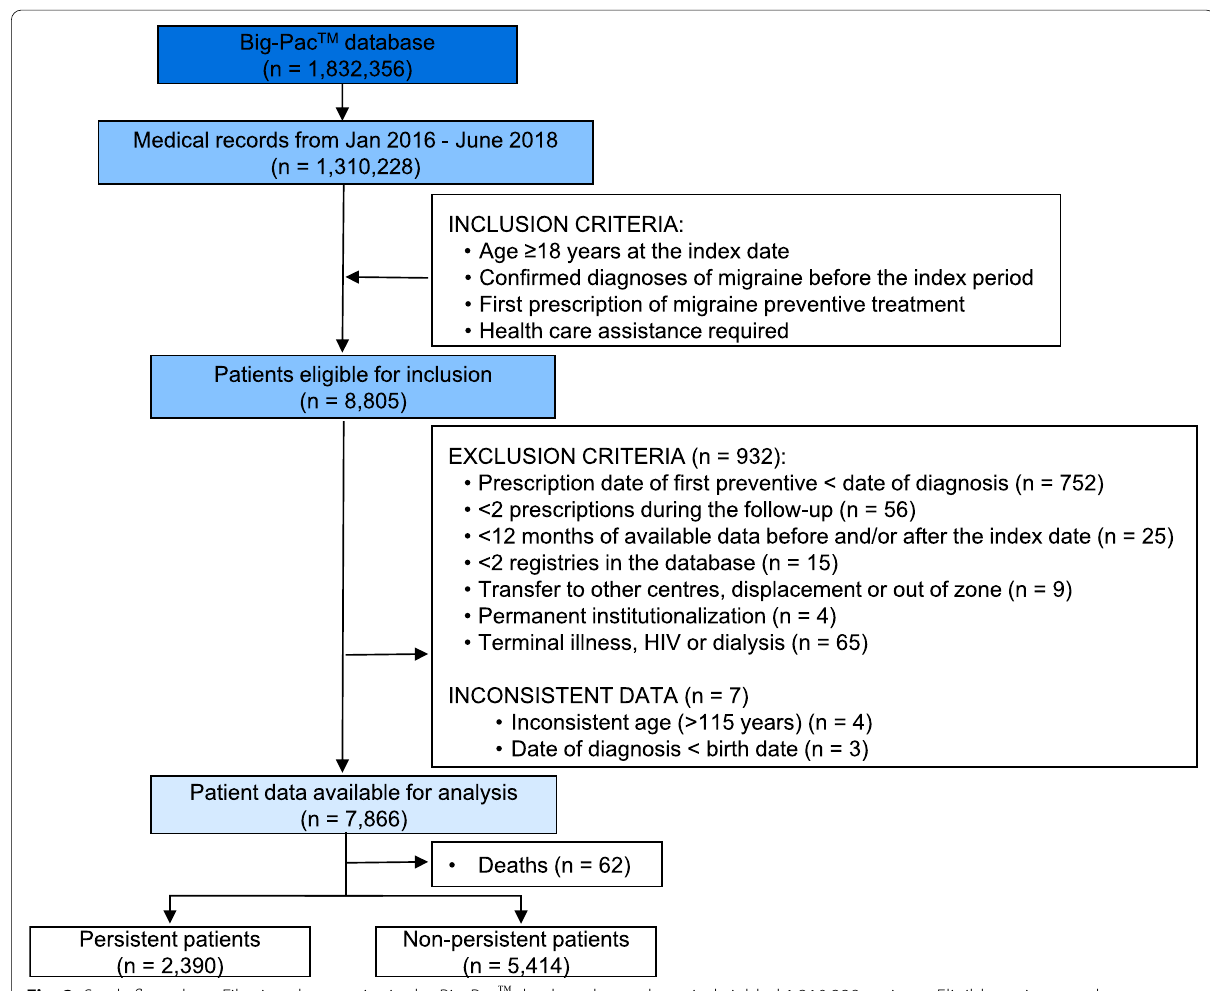
Fig. 2 Study flow chart. Filtering data entries in the Big‑Pac ™ database by study period yielded 1,310,228 patients. Eligible patients